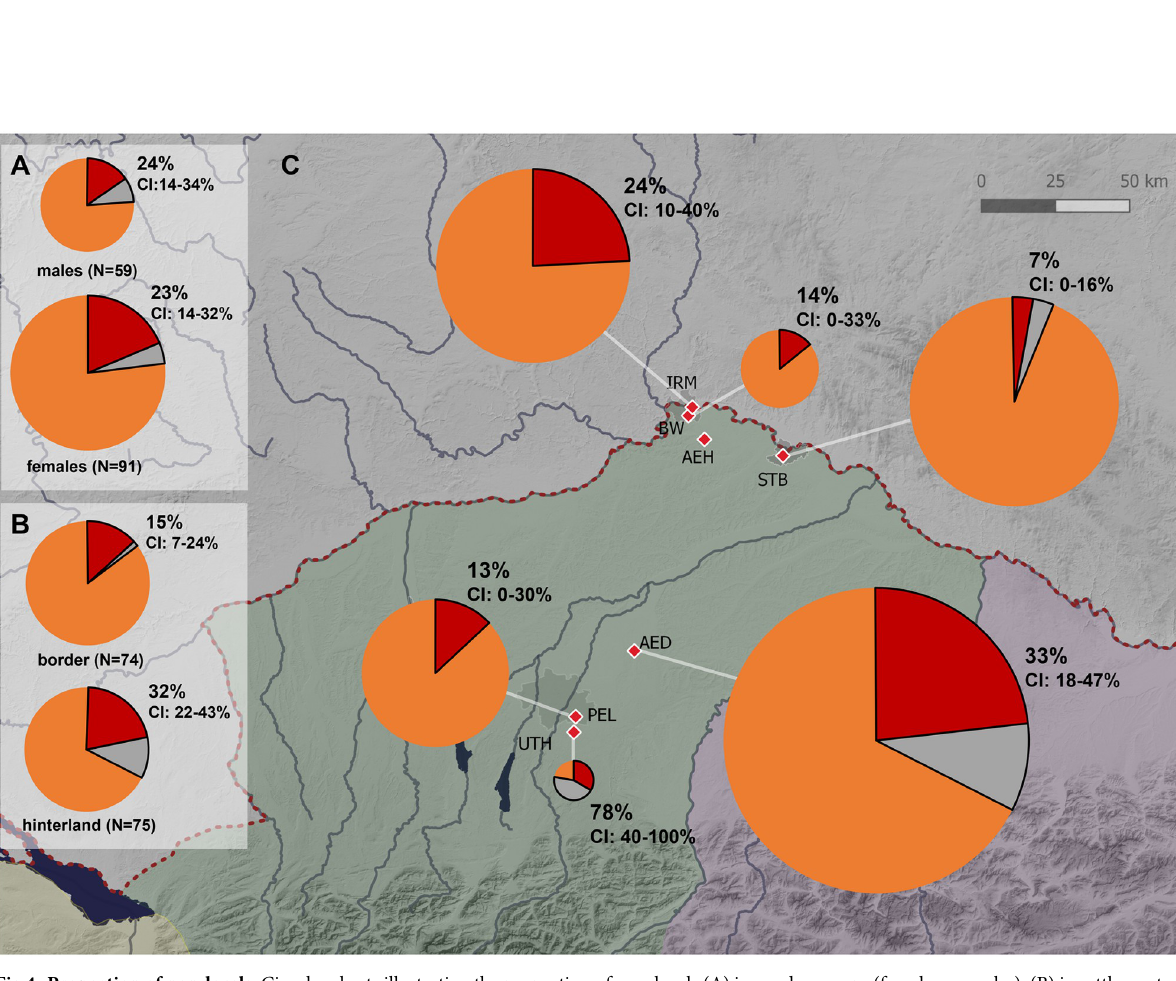
Fig 4. Proportion of non-locals. Circular charts illustrating the proportion of non-locals (A) in gender groups (females vs. males), (B) in settlement zones (border vs. hinterland), (C) for archaeological sites (VW Burgweinting, IRM Irlmauth, STB Straubing-Bajuwarenstraße, AED Altenerding, PEL Munich-Perlach, UTH Unterhaching). Given numbers are frequencies of all non-locals, whose strontium values are found outside the range of their burial region, which summarize the frequencies of individuals who show strontium ratios outside the local range of the Northern Alpine area in South Bavaria (filled in dark red) and individuals whose strontium values are found in other study regions in South Bavaria (filled in grey). (Map data: see Fig 1). (created with QGIS 3.18.3 Zu¨rich and Excel).